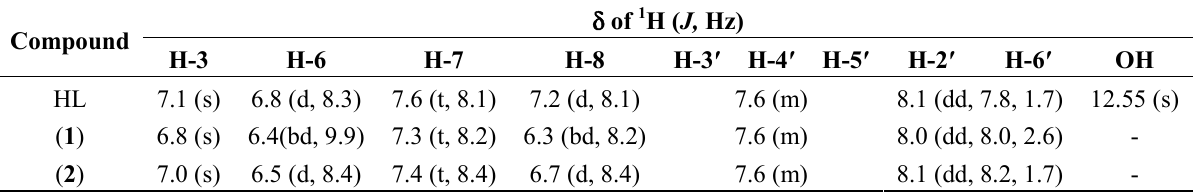
Table 5. The 1 H chemical shifts (ppm) for ligand and complexes. Compound